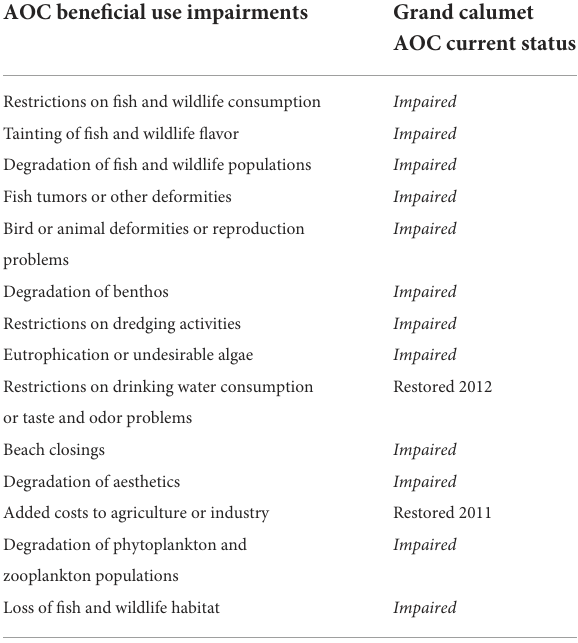
TABLE 2 Beneficial use impairments in the grand calumet area of